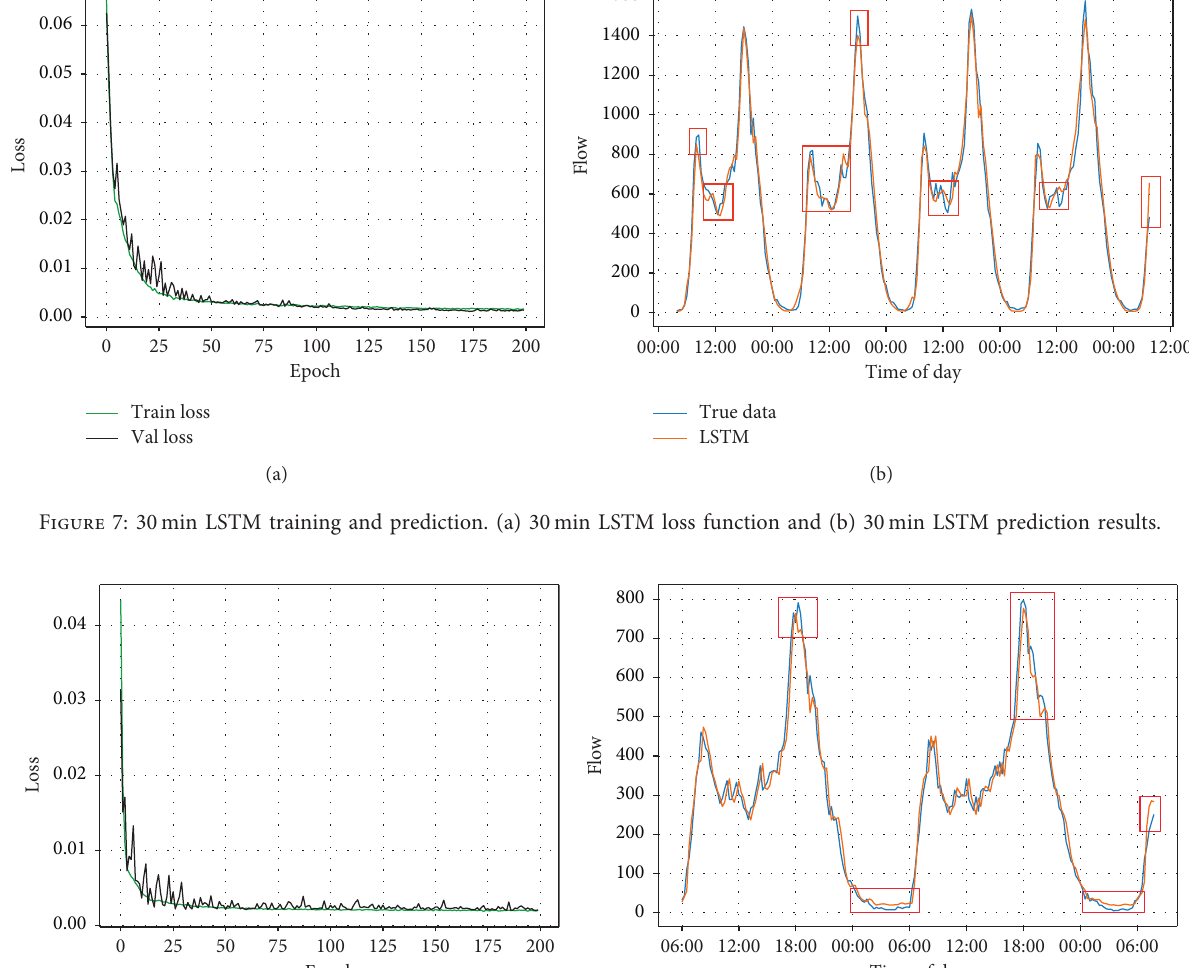
Train loss Val Figure 8: 4 steps LSTM training and prediction. (a) 4 steps LSTM loss function and (b) 4 steps LSTM prediction